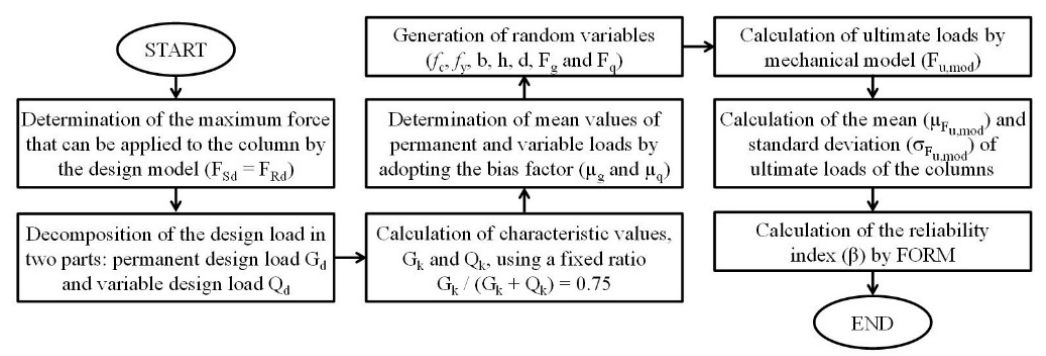
Figure 10. Reliability analysis process by Monte Carlo and